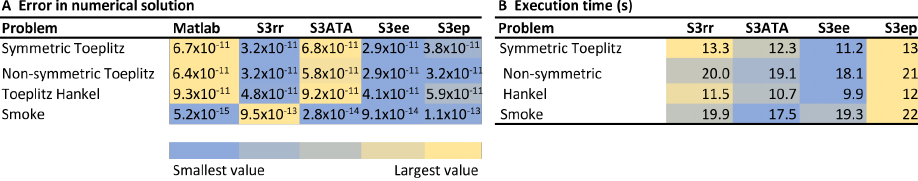
Figure 8. Numerical properties of the four ABS-based variants and the Matlab algorithm for solving 1500-dimensional Matlab Gallery problems. Panel ( A ) shows the computational accuracy. Panel ( B ) shows the execution times for our ABS-based variants in seconds.